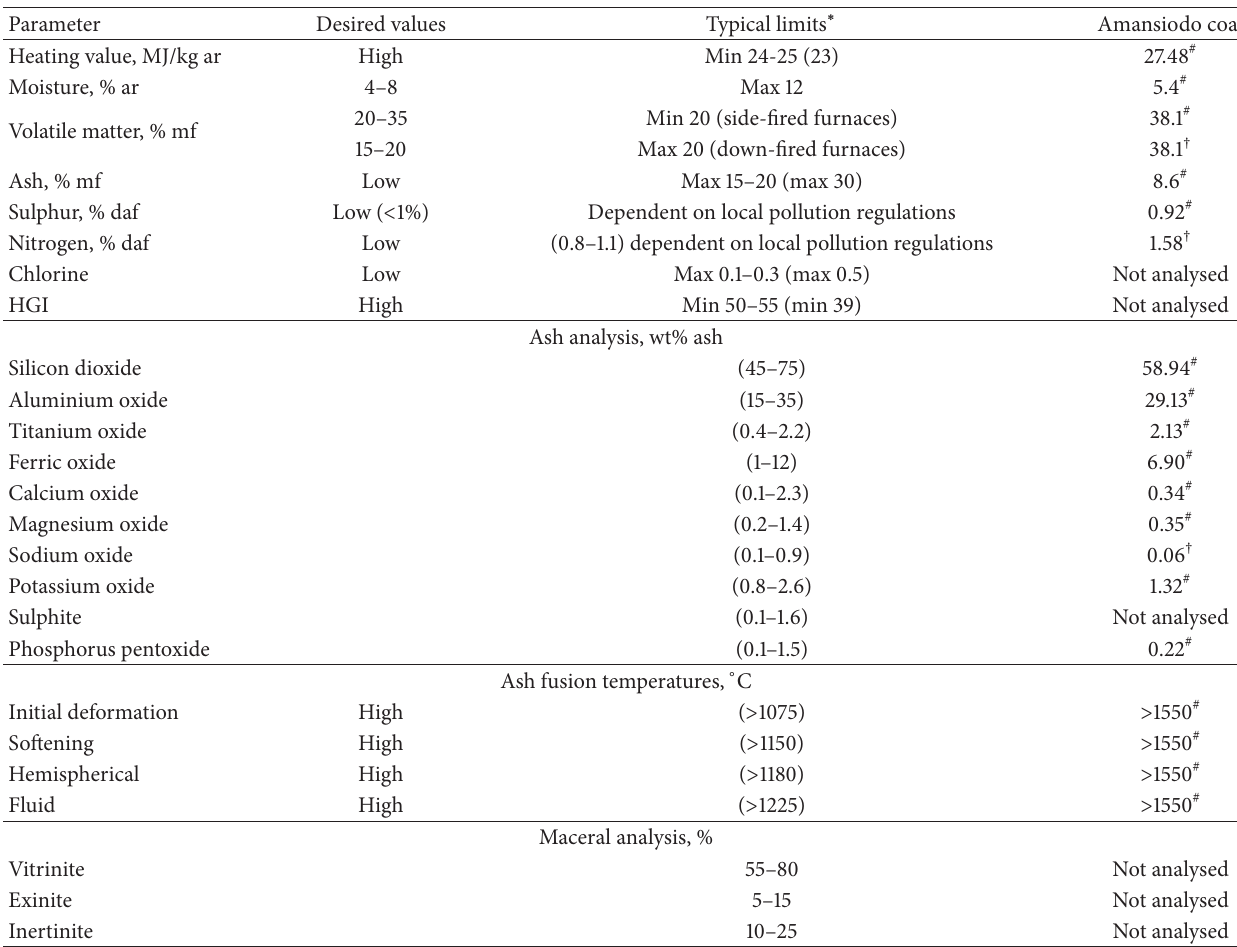
Table 10: Comparison of properties of Amansiodo coal with published bituminous coal quality requirements for pulverised coal-fired plants. Parameter